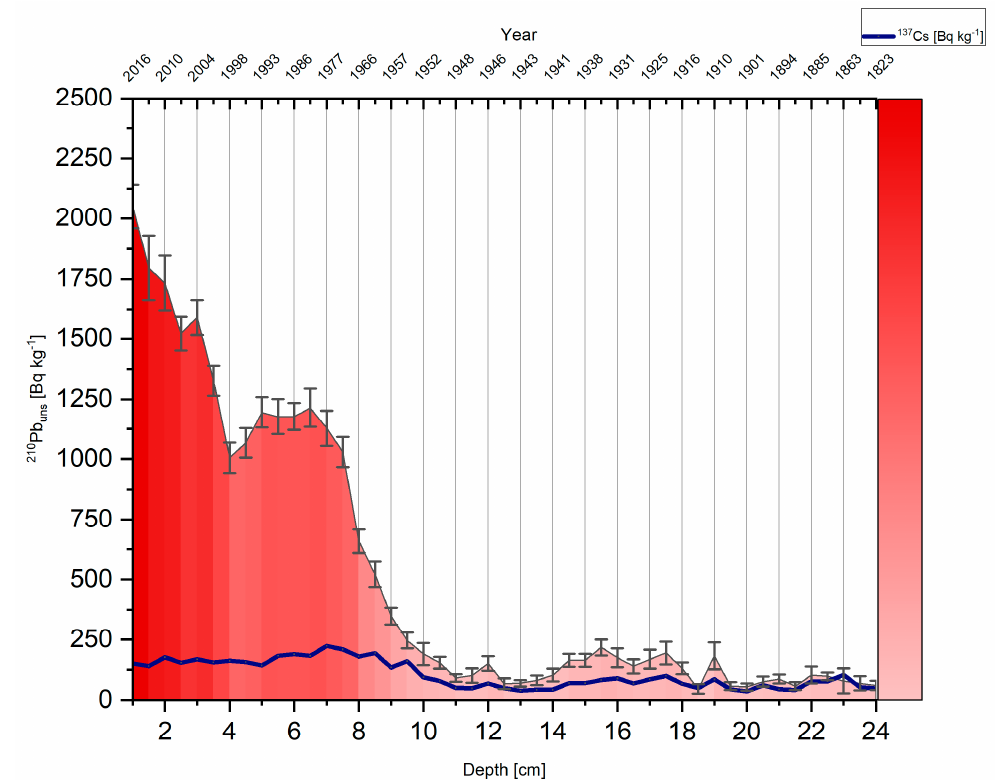
Figure 2. Age-depth model of the sediment sequence from VRP lake showing changes in 210 Pbuns and 137 Cs concentrations in the sediment core samples.